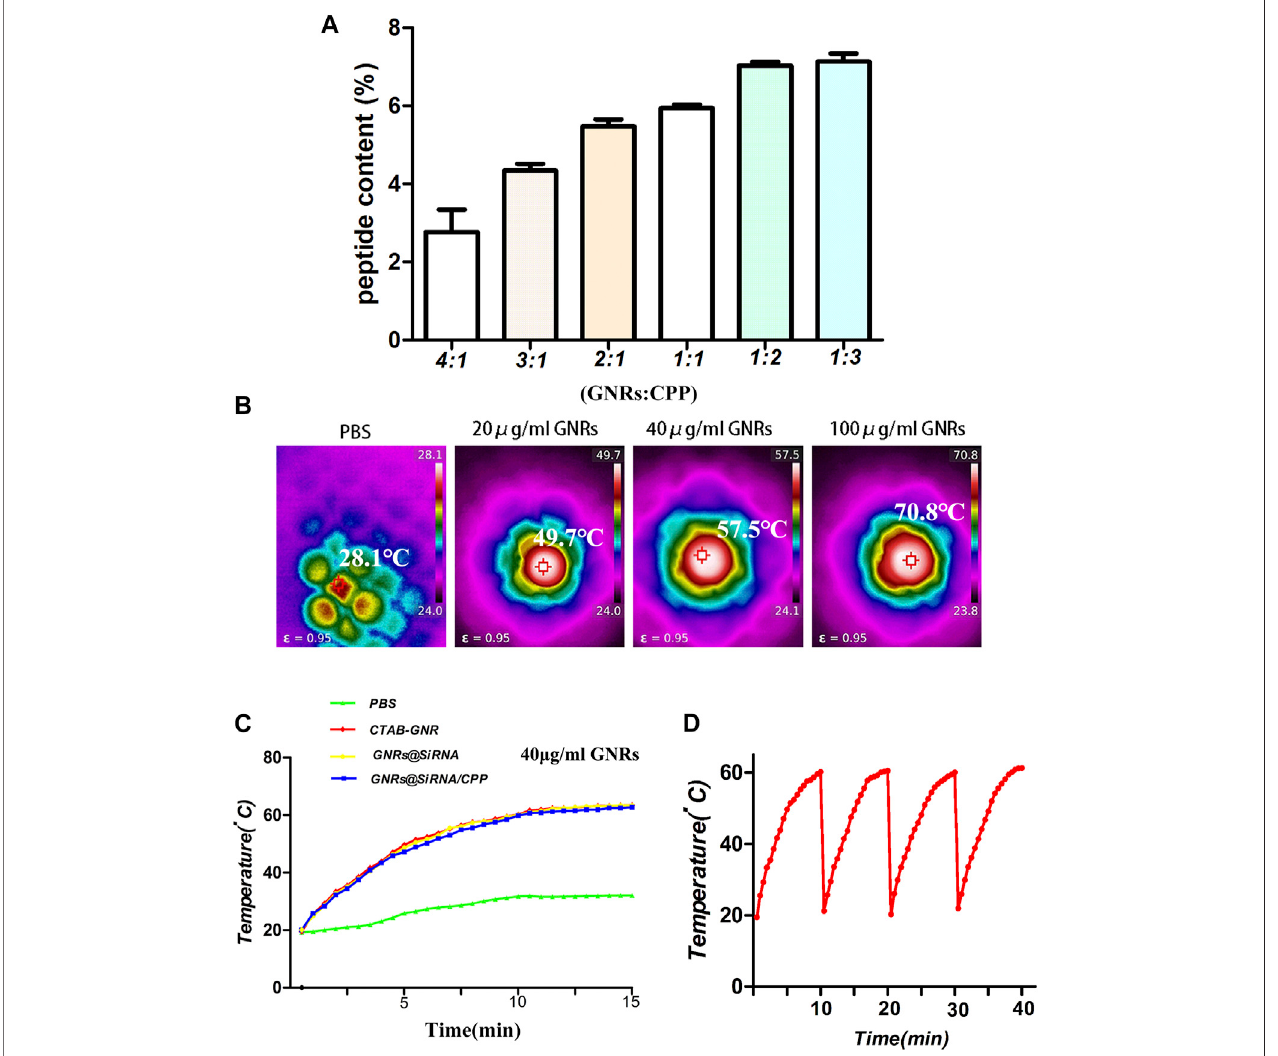
FIGURE2 | Characterization ofthe GNR/CPP complexes. (A) Peptide contenton GNR/CPP complexes surface under various weight ratios. (B) Temperature plot of different concentrations of GNRs irradiated by 808 nm laser irradiation (1 W/cm 2 ). (C) Temperature changes of GNRs and GNR complexes irradiated by 808 nm NIR laser. (D) Temperature change curves of the GNR@siRNA and GNR@siRNA/CPP irradiated by 808 nm laser.